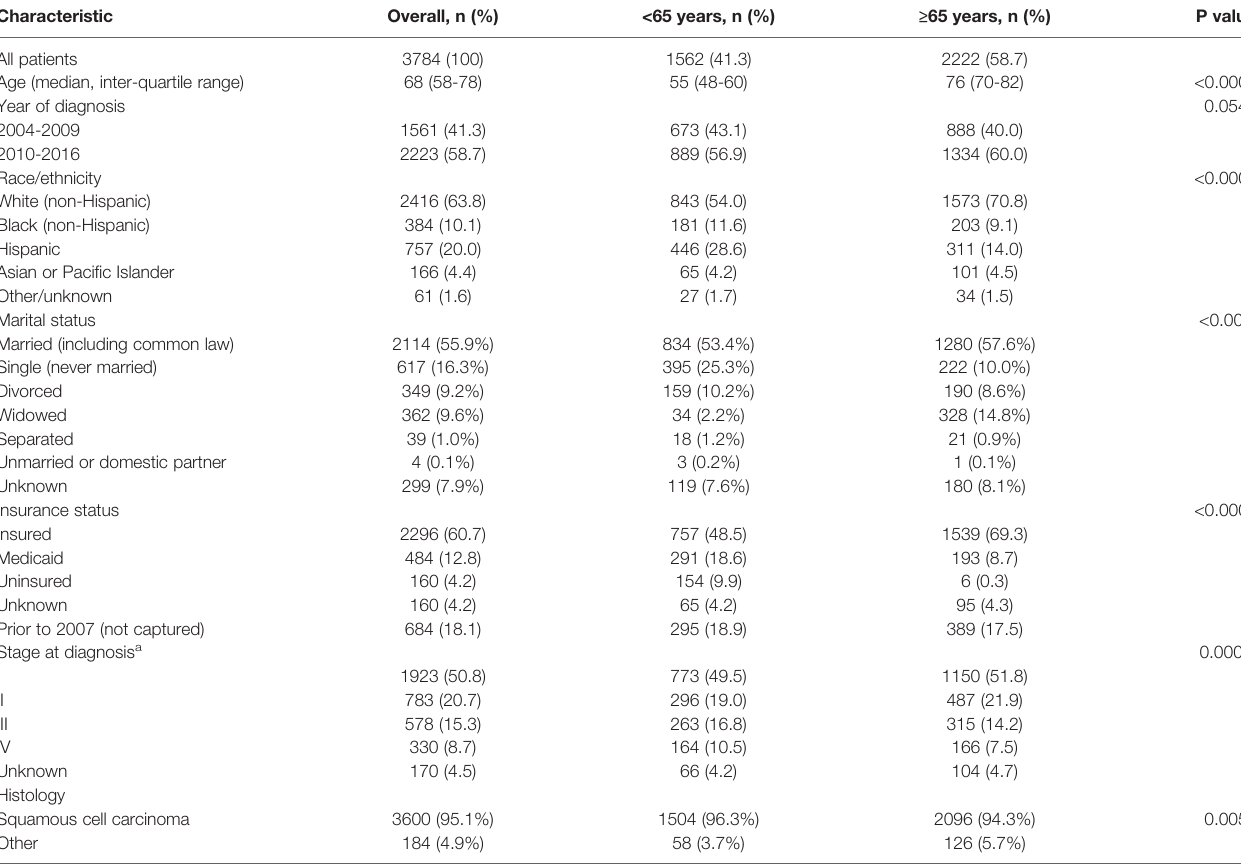
TABLE 1 | Population characteristics according to age at diagnosis (<65 years vs ≥ 65 years). Characteristic Overall, n (%) All